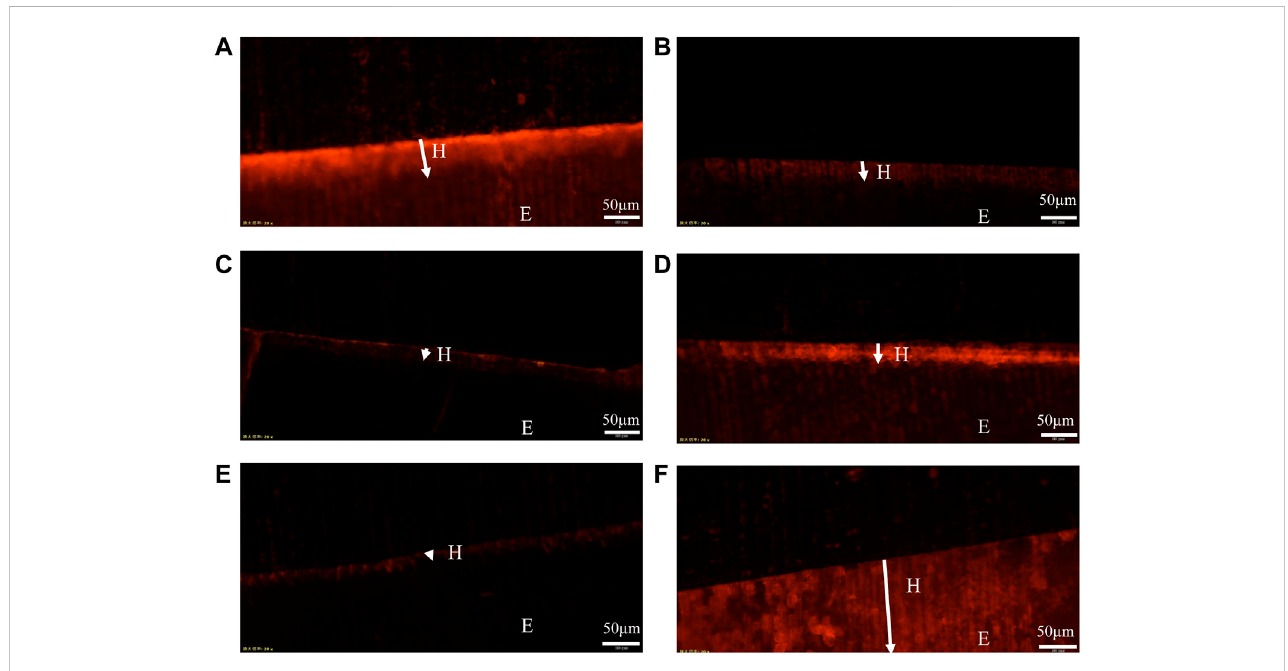
FIGURE 6 Representative FM images. (A) : PAA-ACP@aMBG group sample. (B) : CPP-ACP group sample. (C) : NC group sample. (D) : MBG group sample. (E) : demineralized enamel. (F) : normal enamel. The arrow in the fi gure indicates the remineralization depth (H); E represents the enamel layer.